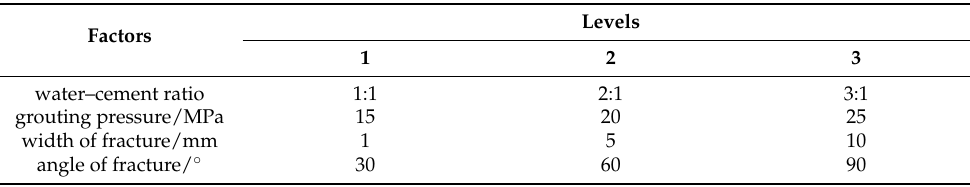
Table 8. Numerical simulation factors and levels.